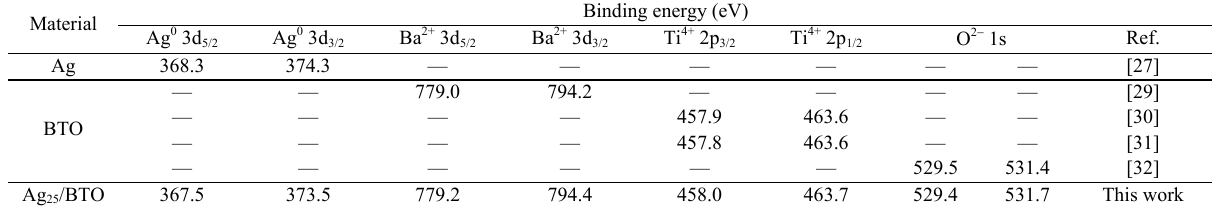
Table 1 XPS data (binding energy) of the Ag 25 /BTO sample compared with reported values